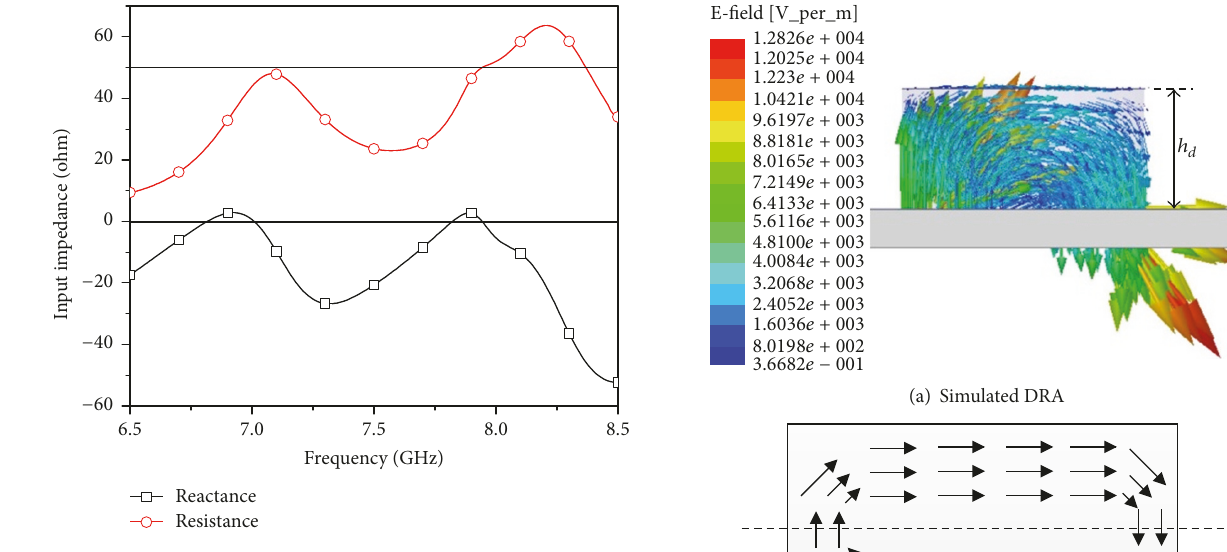
Figure 4: Electric field distribution in the DR (cross-sectional view) indicating HEM 11𝛿